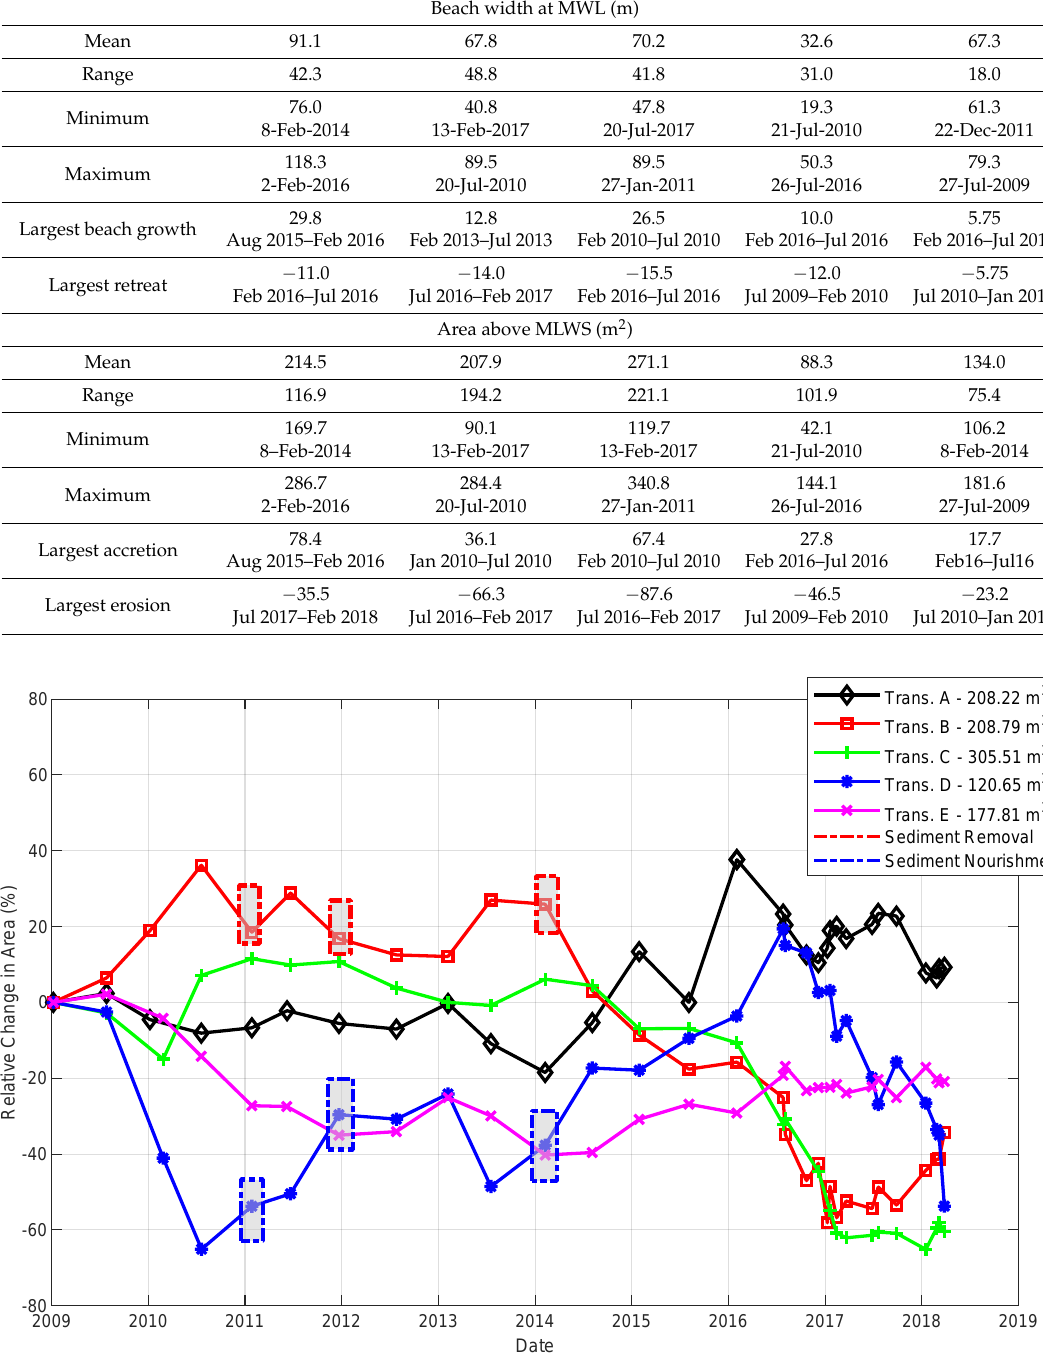
Figure 5. Relative change in profile area above MLWS for Transects A–E for the period between 7-Jan-2009, and 27-Mar-2018 (including dataset 1 and dataset 2), calculated as a proportion of the respective initial area (shown in the legend). Grey boxes indicate beach nourishment and reprofiling in the area of Transect D, with gravel taken from the area of Transect